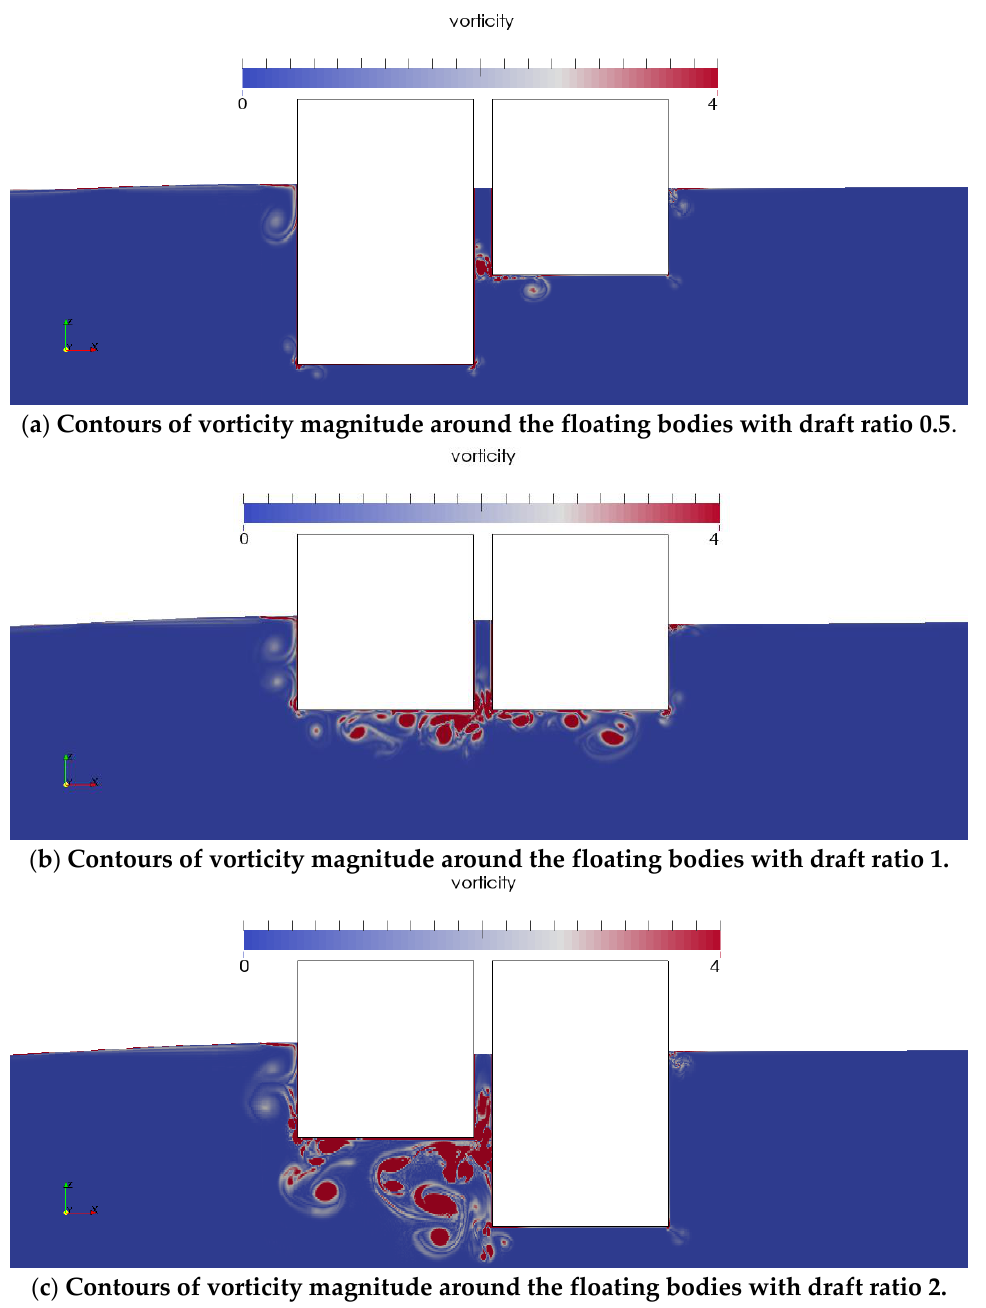
( c ) Contours of vorticity magnitude around the floating bodies with draft ratio 2. Figure 11. Instantaneous contours of vorticity magnitude around the floating bodies with different draft ratios. ( a ) h 2 / h 1 = 0.5, ( b ) h 2 / h 1 = 1.0, ( c ) h 2 / h 1 =